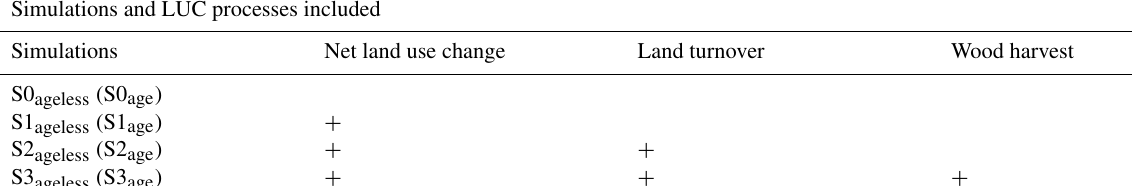
Table 1. Factorial simulations to quantify E LUC from each of the LUC processes considered: net land use change ( E LUC net ), land turnover ( E LUC turnover ), and wood harvest ( E LUC harvest ), with E LUC all being carbon emissions from all three processes. The plus signs ( + ) indicate that the process in question is included, with S0 ageless (S0 age ) having no LUC activities to S3 ageless (S3 age ) including all LUC processes. E LUC is quantified as the difference in net biome production (NBP) between simulations without and with LUC. To explore the uncertainties by using a fully additive approach, we included an alternative S2b simulation, which includes net land use change and land turnover. E LUC turnover and E LUC harvest are consequently calculated using this alternative simulation as well.